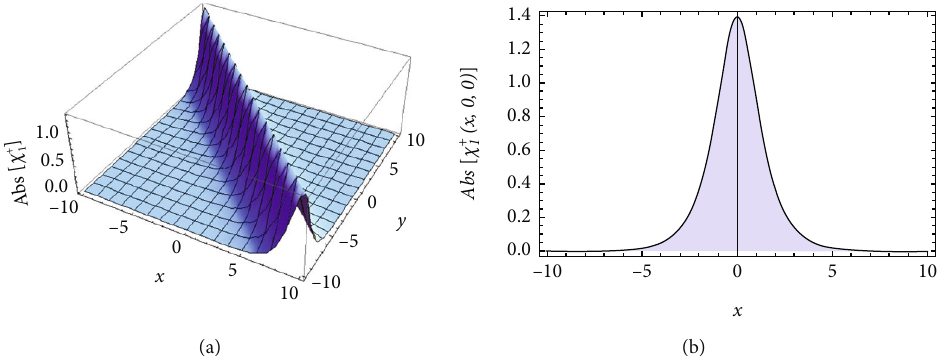
x , y , t Þj with the parameters λ = 1 , v = 1 , v 1 ð